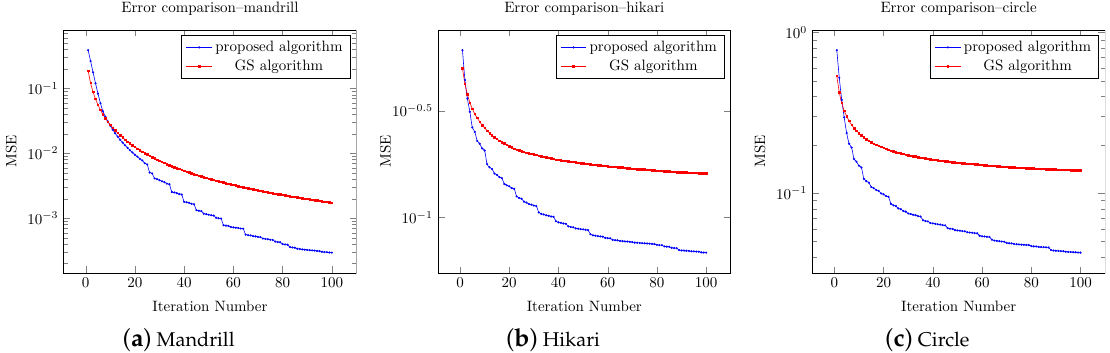
Figure 7. Change in mean square error (MSE) during the optimization process for three target images: ( a ) mandrill, ( b ) hikari, and ( c )